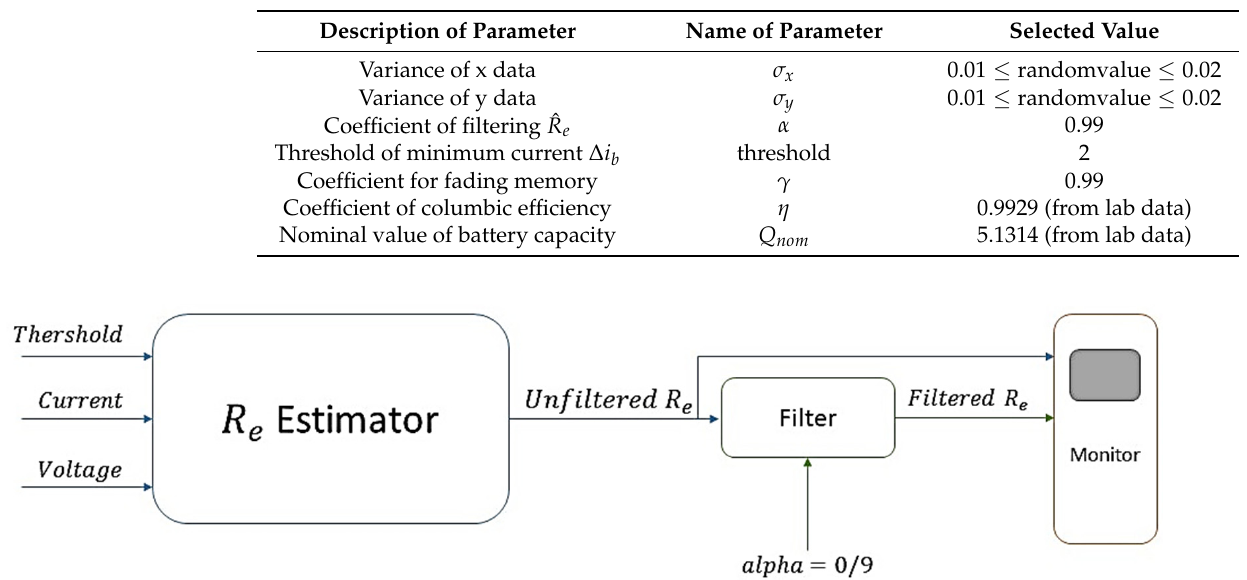
Table 1. Parameter quantification.